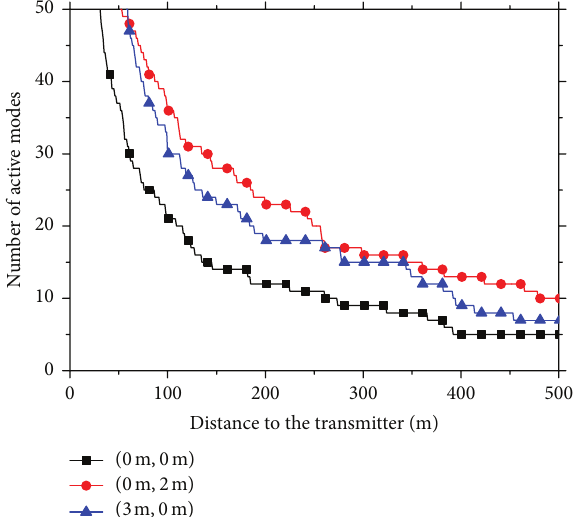
Figure 9: Comparison of the normalized amplitude distributions of active modes tested with different antenna locations in the plane of 𝑧 = 1000 m using the proposed modal